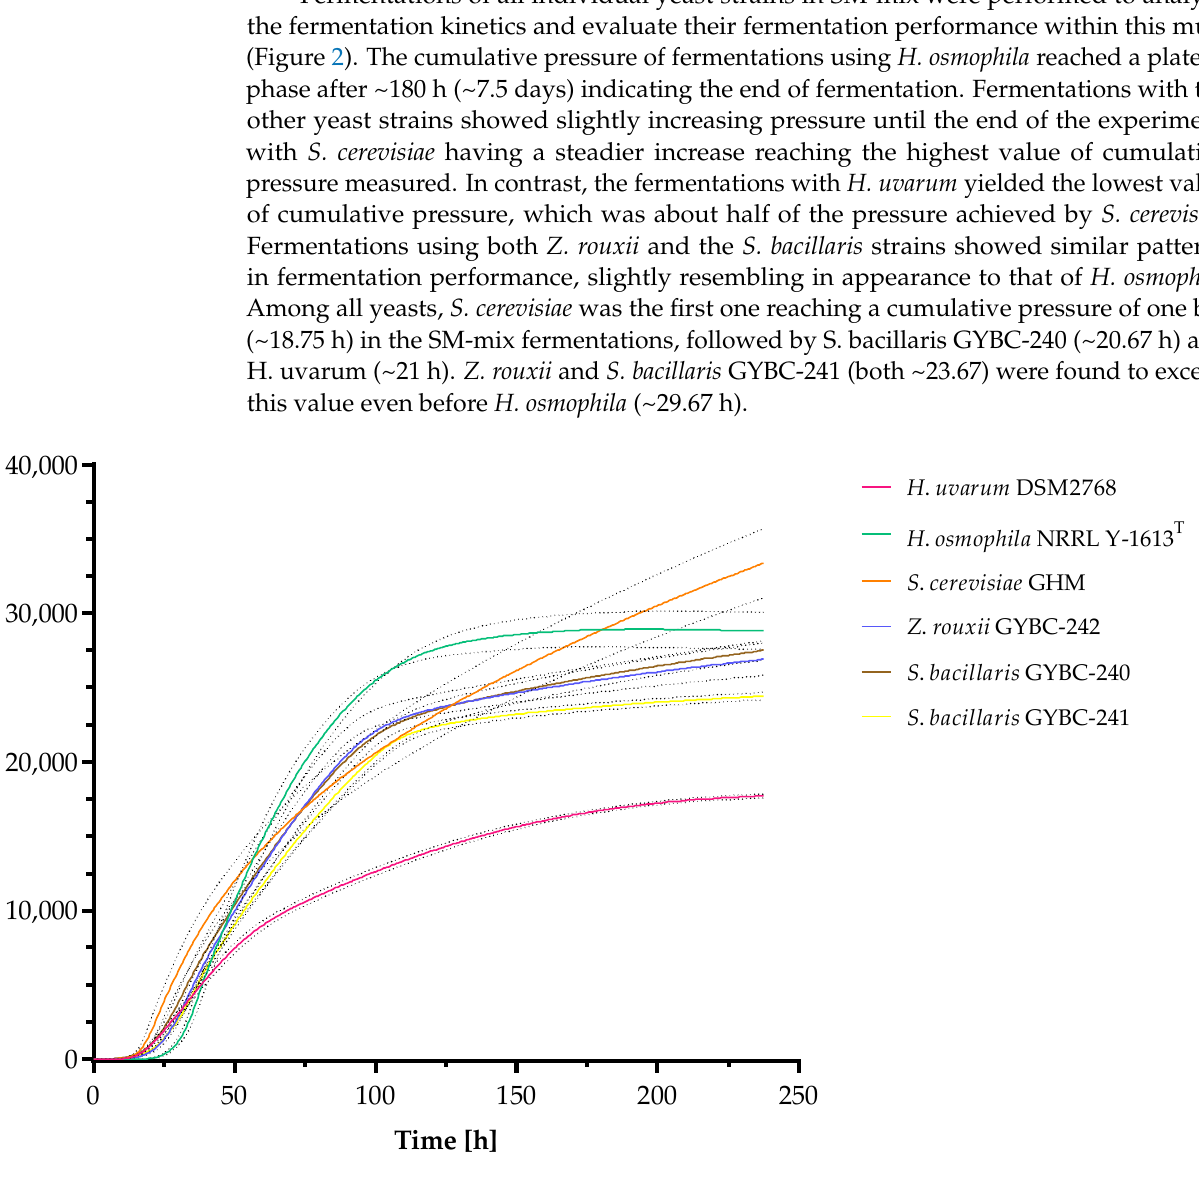
Figure 2. Fermentation kinetics of fermentations with SM-mix. Cumulative pressure was measured using ANKOM Rf Gas Production system. Data are the mean of three independent experiments ± SEM. Dashed lines indicate the standard deviation.